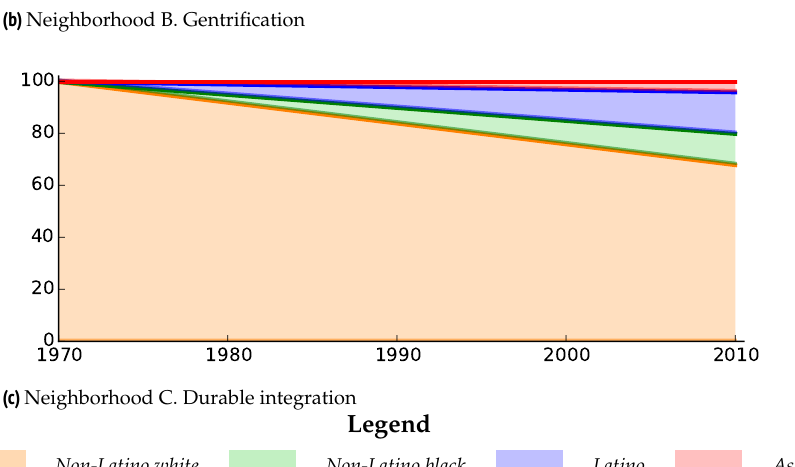
sociological science |